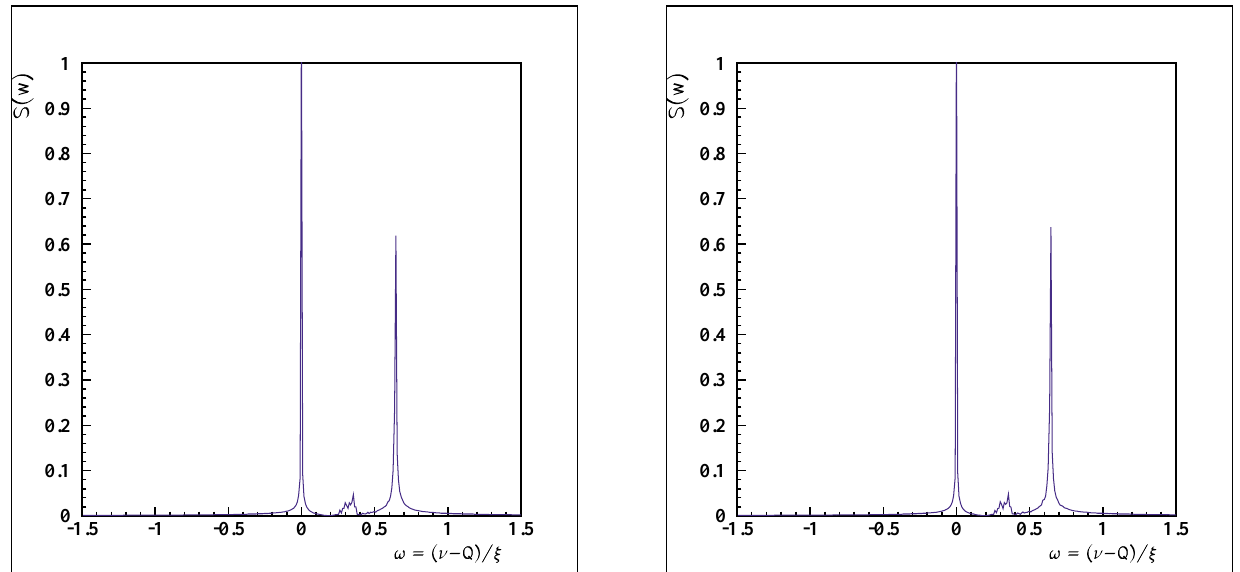
FIG. 8. (Color) Spectrum of the horizontal centroid motion for long-range collisions with horizontal separation L x (cid:1) 10.0 (in units of s x ) and no head-on collision ( 2 15 turns, N (cid:1) 10 4 macroparticles). For the left figure the grid did not cover both separated beams; i.e., the particles in the second beam were treated as halo particles. In the right figure the grid covered both